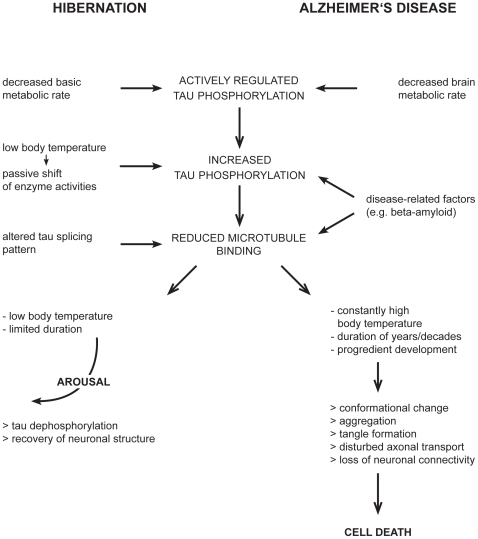
Schematic illustration comparing the cellular consequences of physiological (hibernation) and pathological (AD) tau phosphorylation.